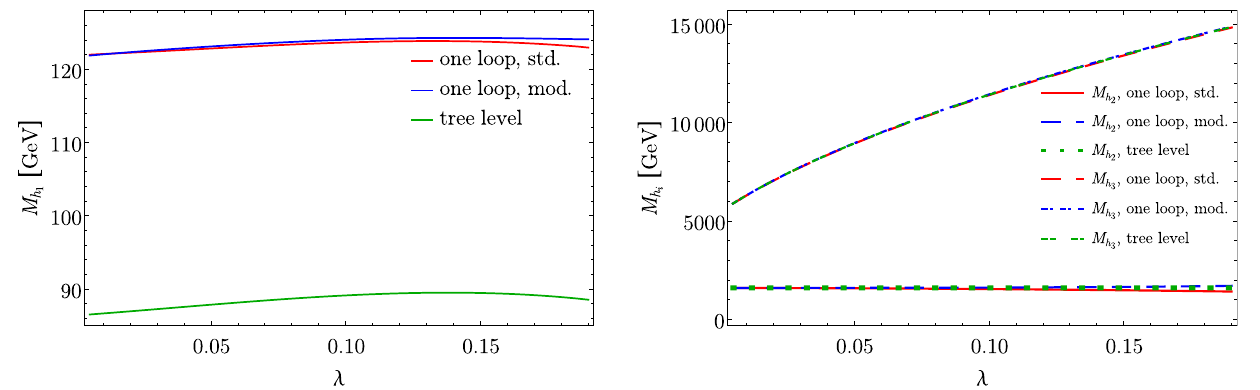
the pole masses computed at one loop, respectively with the standard and modified approaches to the tadpoles